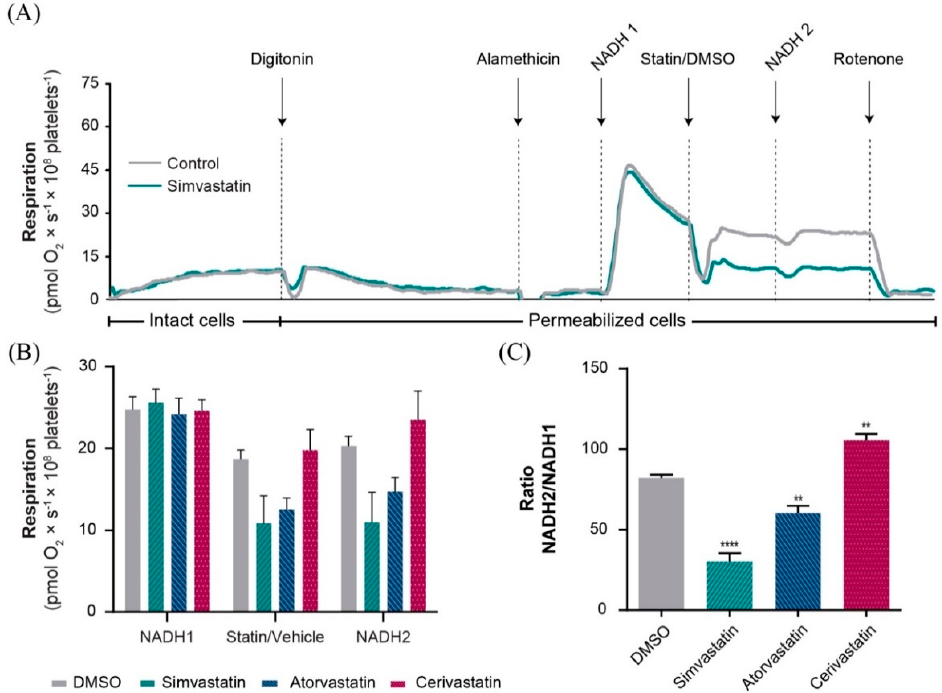
Figure 3. Statin effects on NADH − linked oxygen consumption in alamethicin-permeabilized platelet mitochondria. ( A ) Representative trace of simvastatin 160 µ M (green) and DMSO (grey). ( B ) Oxygen consumption of permeabilized platelet mitochondria was measured at three points: Figure 0. mM) next in the presence of the statin (160 µ M)/DMSO control (DMSO-grey bar, simvastatin-green bar, atorvastatin-blue bar, cerivastatin-red bar) and then after the addition of statin plus a second dose of NADH (0.75 mM). ( C ) Calculated NADH-linked oxygen consumption ( ∆ ) for each statin and DMSO control, evaluated as the ratio between the two consecutive additions of NADH (NADH2/NADH1). Data is expressed as mean ± SEM of rotenone-corrected data, one-way ANOVA with Bonferroni post hoc test. DMSO, dimethyl sulfoxide. ** p < 0.01; **** p < 0.001 vs. DMSO.